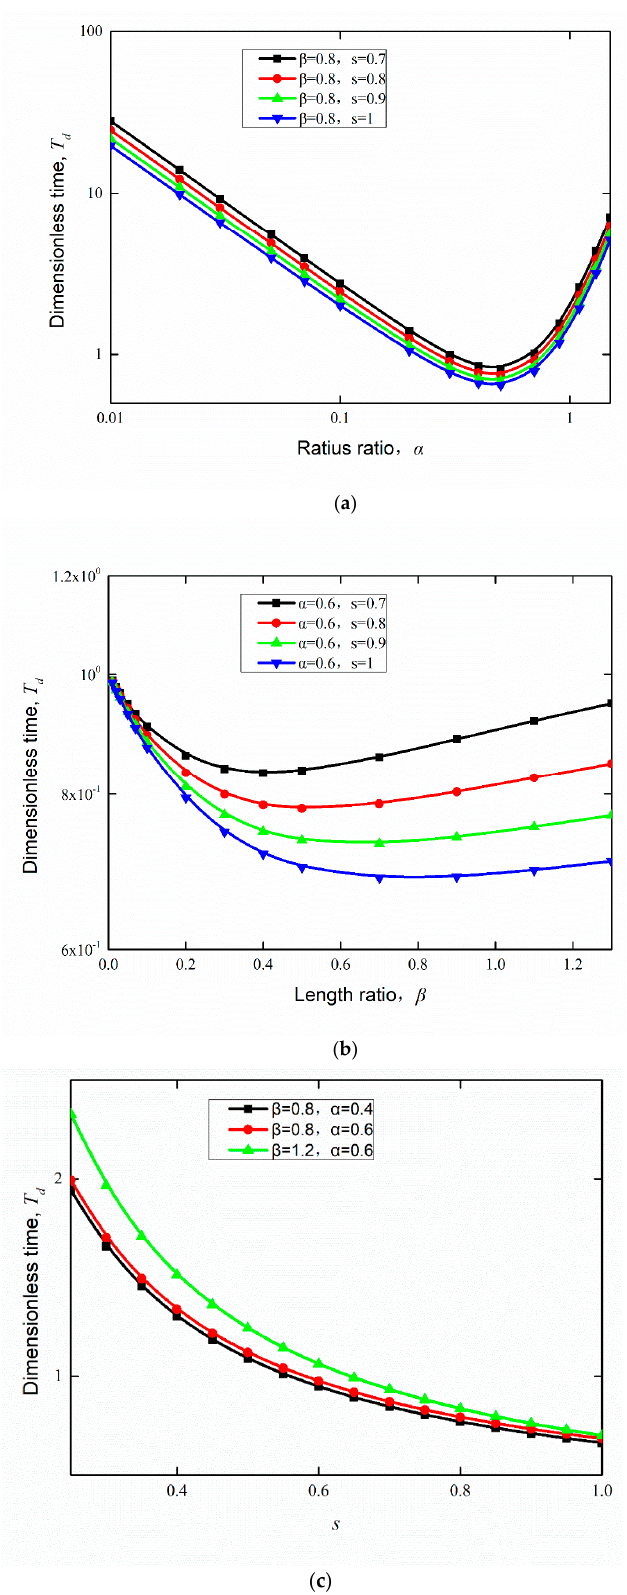
Figure 3. Dimensionless time curves of capillary flow at n = 2. ( a ) The effect of radius ratio α at different s values, ( b ) the effect of length ratio β at different s values, and ( c ) the effect of radius s values at different radius ratios α and length ratios β .